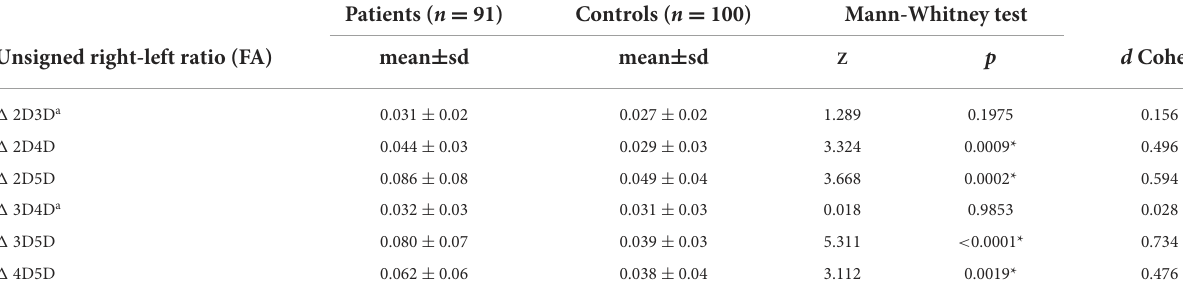
TABLE 5 Digit ratios’ asymmetries in patients and the controls. Patients ( n = 91) Controls ( n = 100) Mann-Whitney test Unsigned right-left ratio (FA) mean ± sd